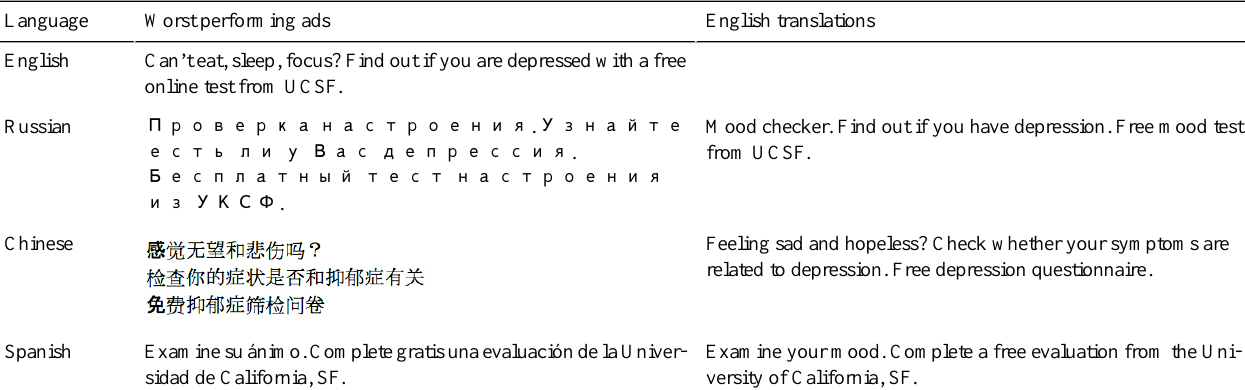
English translationsWorst performing adsLanguage